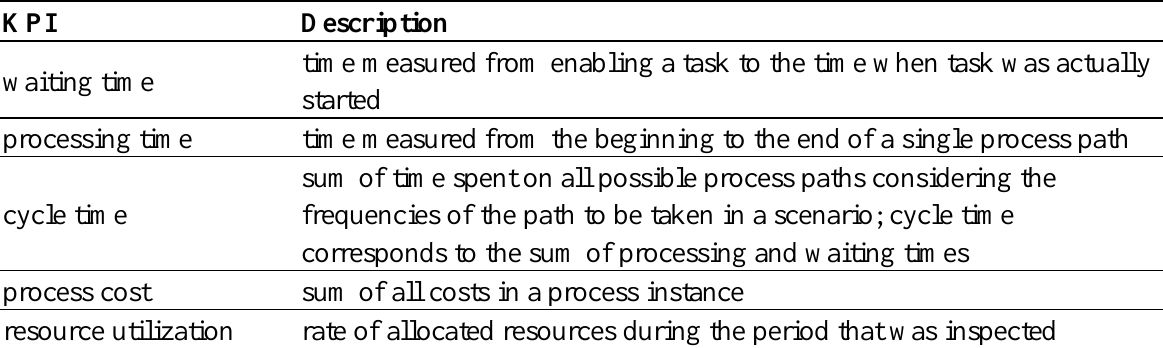
Table 2. Some general purpose key performance indicators. KPI, key performance indicator.